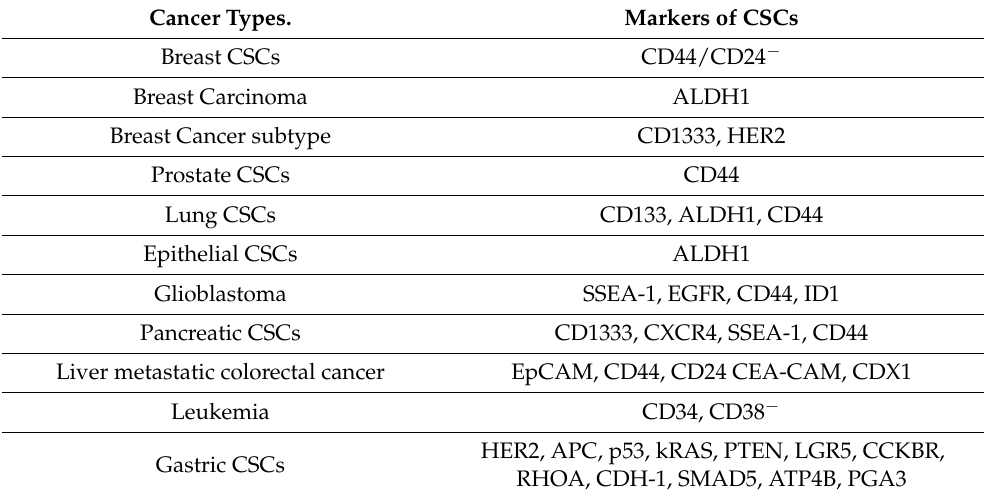
Table 1. Representative biomarkers in each cancer cells. We have modified to add the items based on the following references by Zhao et al. [69], Walcher et al. [44], and ours [1,16]. Cancer